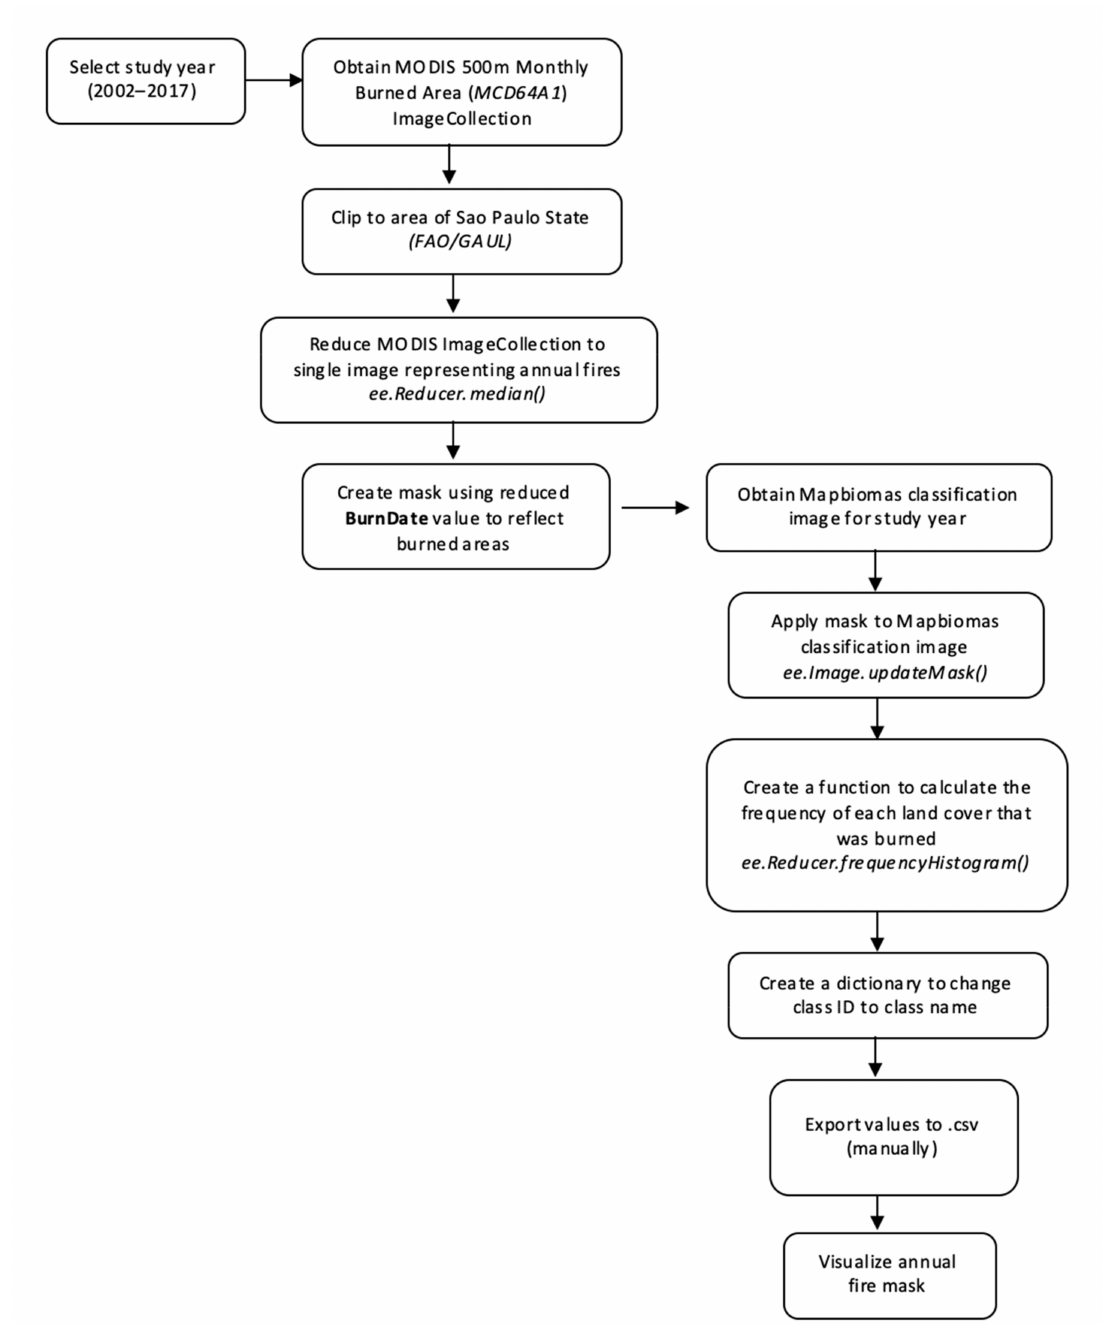
Figure 3. Methodological flow chart used for calculating and extracting the count of pixels representing each type of land use and land cover classified in the study